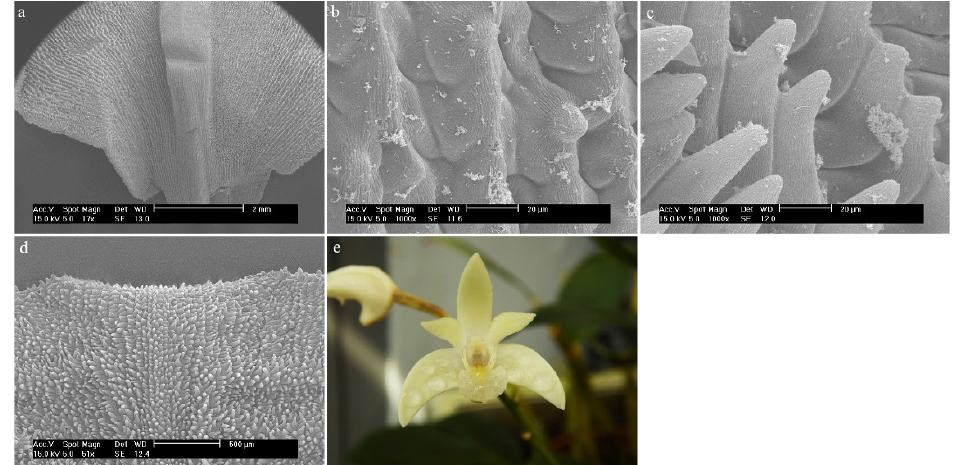
Figure 13. Dendrobium × delicatum (F.M.Bailey) F.M.Bailey: papillae ( a ) of the hypochile and the mesochile part of the labellum; ( b ) of the hypochile part of the labellum, ( c ) of the mesochile part of the labellum; ( d ) of the epichile part of the labellum; ( e ) flower (photo by Monika Lipi ń ska).